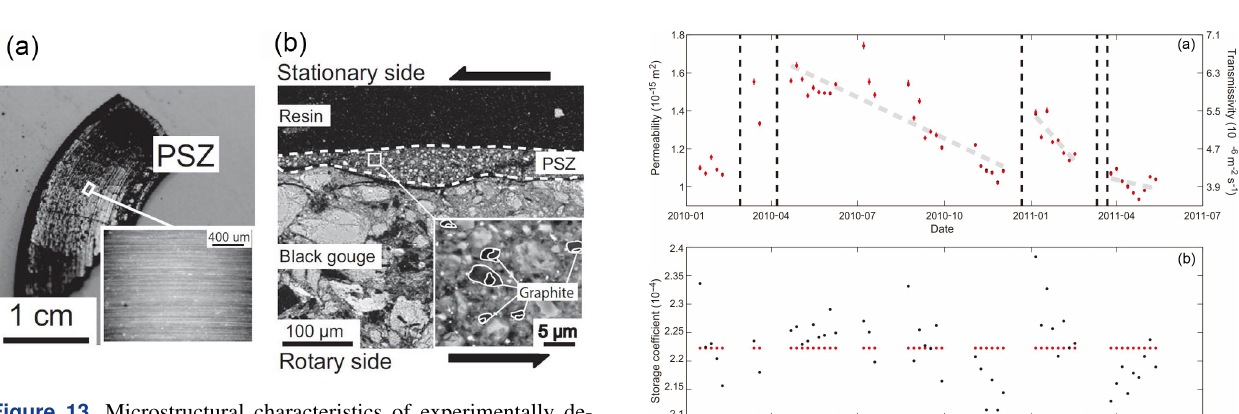
Figure 13. Microstructural characteristics of experimentally de- formed black gouges at 15MPa (Kuo et al., 2014). (a) Photograph of highly reflective surface of the principle slip zone (PSZ) lined by slicken lines and grooves that track the rotary motion of the gouge holder. (b) Backscattered scanning electron microscope (SEM) im- age of a thin section. The fine-grained PSZ developed adjacent to the stationary side of the gouge holder. Inset backscattered SEM image shows occurrence of small graphite particles by heating of carbonaceous materials (mainly anthracite) during experiments.